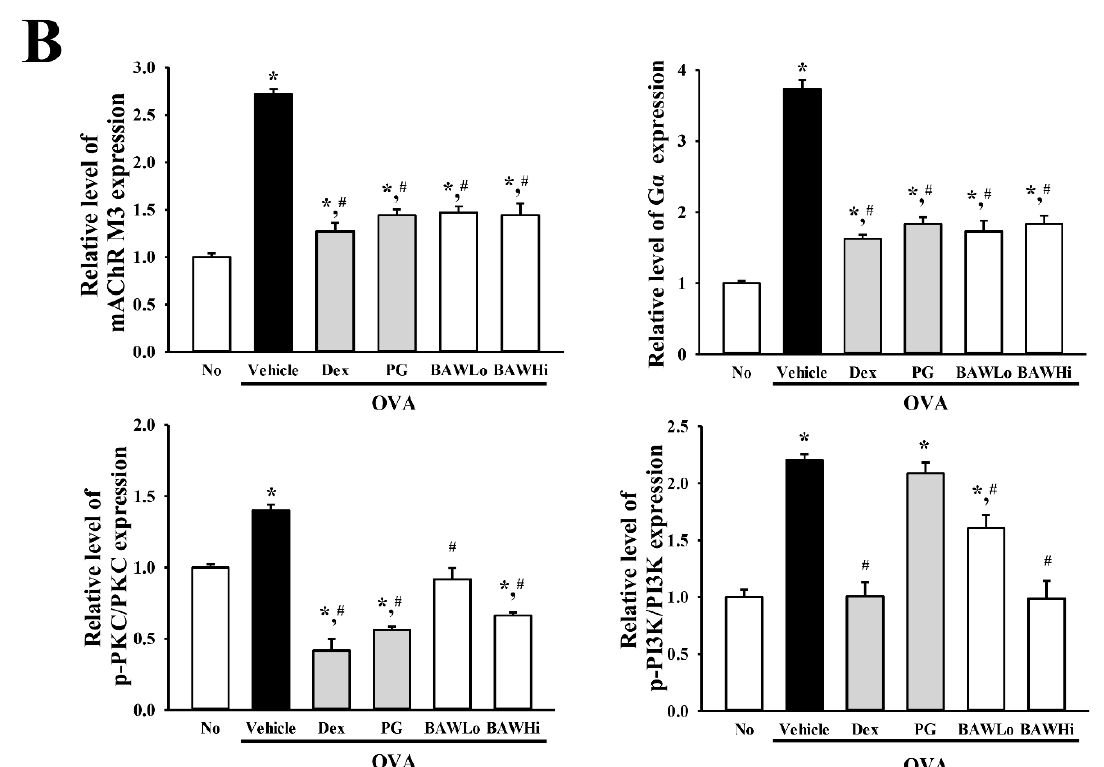
Figure 8. AChR M3 downstream signaling pathway in epithelial cells. ( A ) Expression of key components in the mAChR M3 downstream signaling pathway. Alterations in the expression of proteins related to the mAChR M3 signaling pathway were determined using western blot assays with an HRP-labeled anti-rabbit IgG antibody. ( B ) Band intensities were determined using an imaging densitometer, and the expression levels of the six proteins were evaluated relative to the intensity of actin bands. The data shown represent the means ± SD ( n = 8). * indicates p < 0.05 compared to the No-treated group. # indicates p < 0.05 compared to the OVA + Vehicle-treated group.